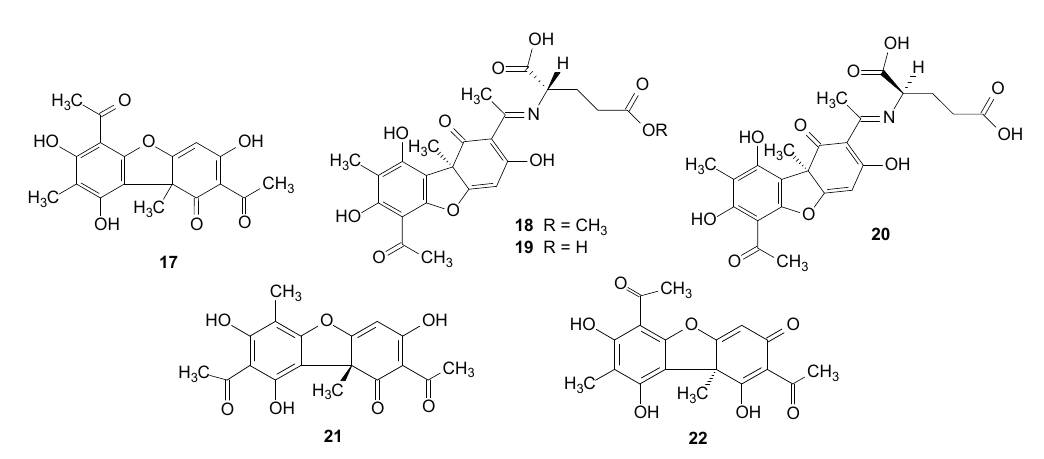
Figure 2. Chemical structures of usnic acid and derivatives from Ramalina species of lichenized